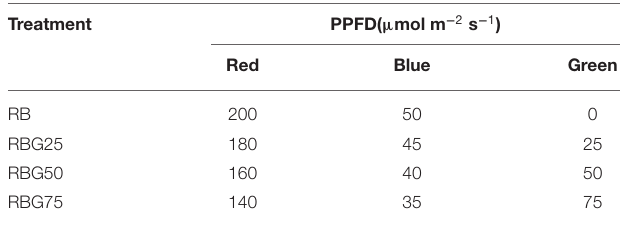
TABLE 1 | Total photosynthetic photon flux density (PPFD) and PPFD of red (660nm), blue (450nm), and green (530nm) for each light treatment.